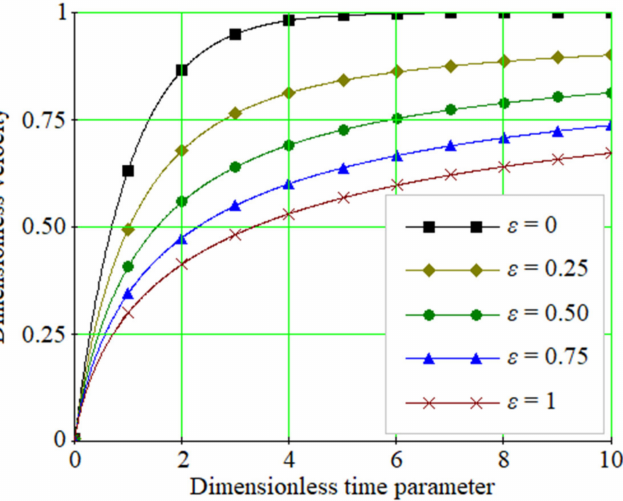
Figure 1. Comparative analysis of the dimensionless solutions for the fractional-order integro- differential equations of particle